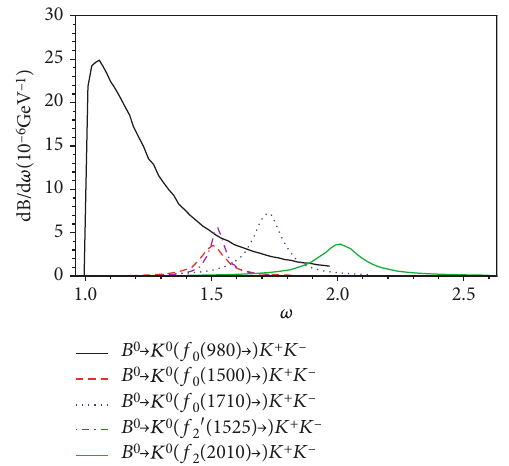
Figure 4: The ω -dependence of di ff erential branching fractions from f 0 ð 980 Þ , f 0 ð 1500 Þ , f 0 ð 1710 Þ , f 2 ′ ð 1525 Þ , and f 2 ð 2010 Þ for the B 0 ⟶ K 0 K + K − decay [20].